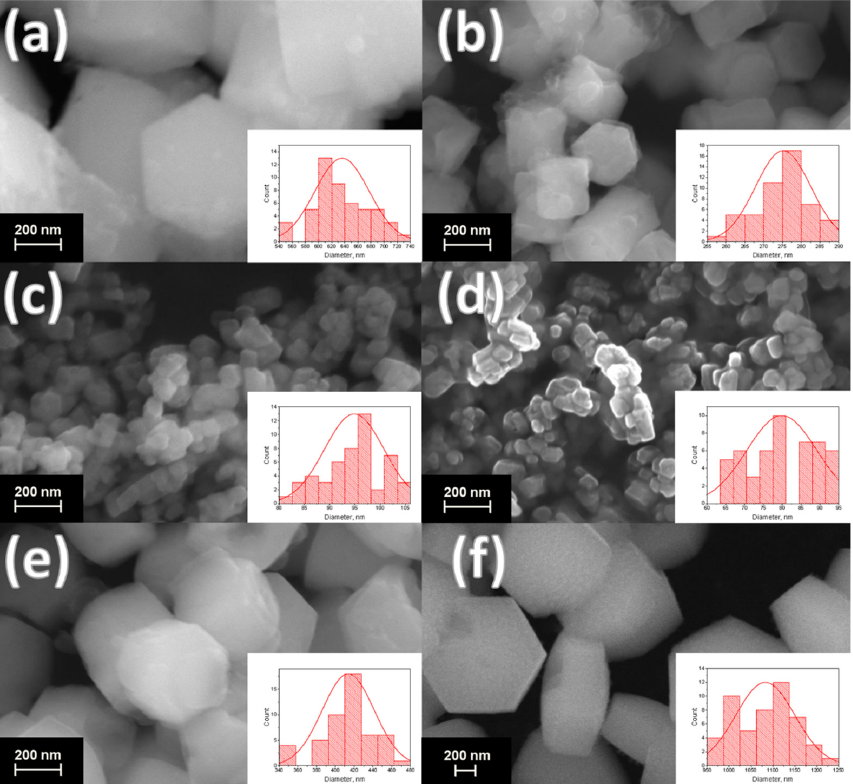
Figure 4. SEM images of the samples: ( a ) NaY 0.6 La 0.4 F 4 , ( b ) NaY 0.6 Pr 0.4 F 4 , ( c ) NaY 0.6 Sm 0.4 F 4 , ( d ) NaY 0.6 Gd 0.4 F 4 , ( e ) NaY 0.6 Ho 0.4 F 4 , ( f ) NaY 0.6 Lu 0.4 F 4 . Particle size distribution is shown in the insets. The average diameter of the particles is equal to 636 ± 41, 95 ± 6, 81 ± 4, 80 ± 9, 177 ± 8 and 1083 ± 67 nm for the La 3+ , Pr 3+ , Sm 3+ , Gd 3+ , Ho 3+ and Lu 3+ , respectively.